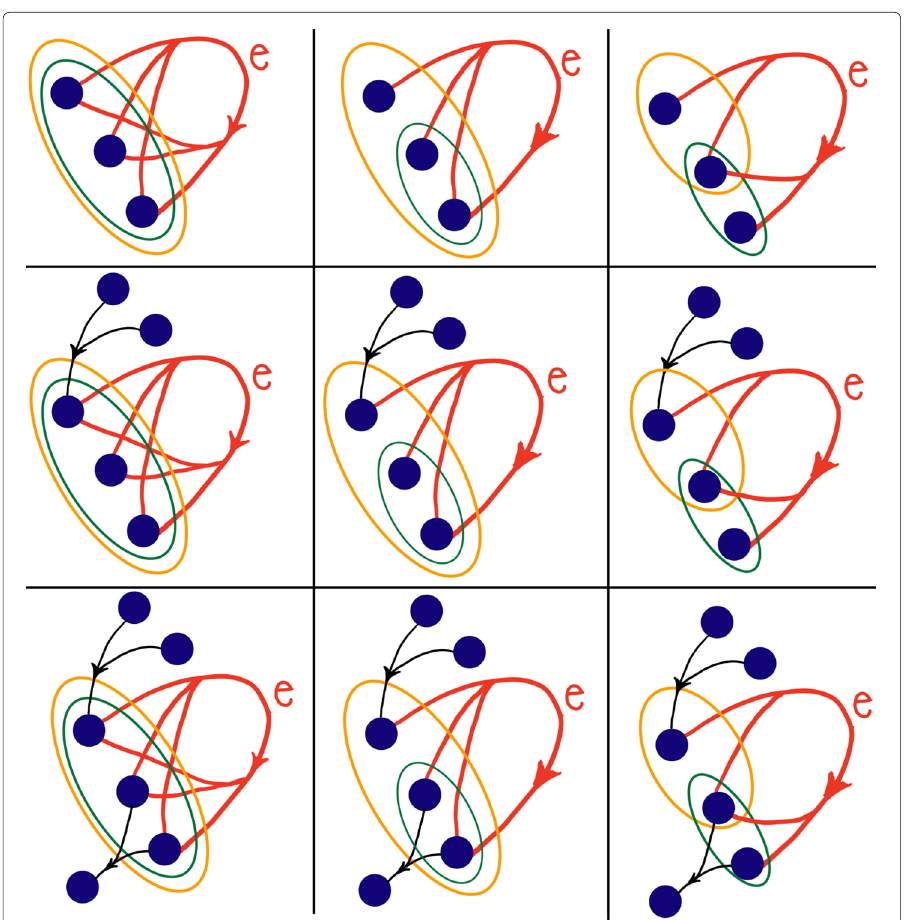
Fig. 2 Hyperloops and their curvature. The following are the values from left to right in rows. First row: F ( e ) = 0,1,2, while O ( e ) = 1.0,0.4444,0.25. Second row: F ( e ) = − 1,0,1, and O ( e ) = 0.7222,0.1111, − 0.25. Third row: F ( e ) = − 3, − 2, − 1, and O ( e ) = 0.2777, − 0.3888, −